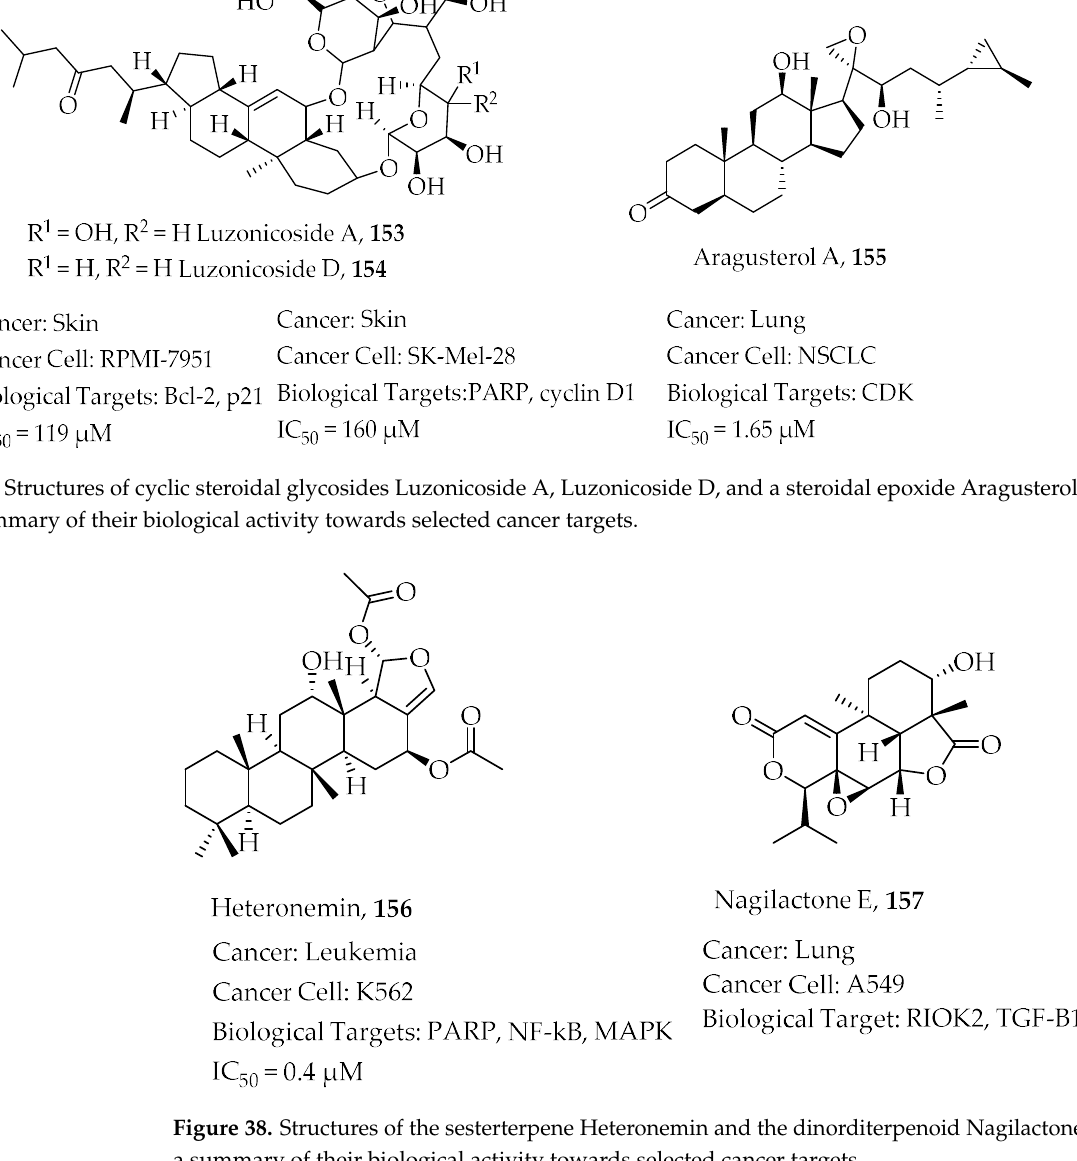
Figure 38. Structures of the sesterterpene Heteronemin and the dinorditerpenoid Nagilactone E with a summary of their biological activity towards selected cancer targets.